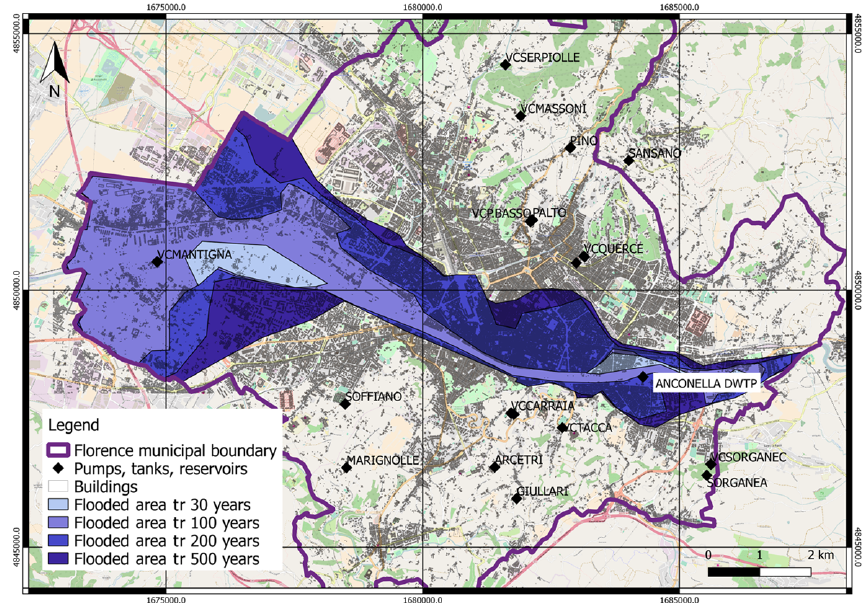
Figure 3. Flooded area for the four recurrence intervals and exposure of vulnerable components. Areas with water depth above 0.01m are considered to be flooded). Reference coordinate system is